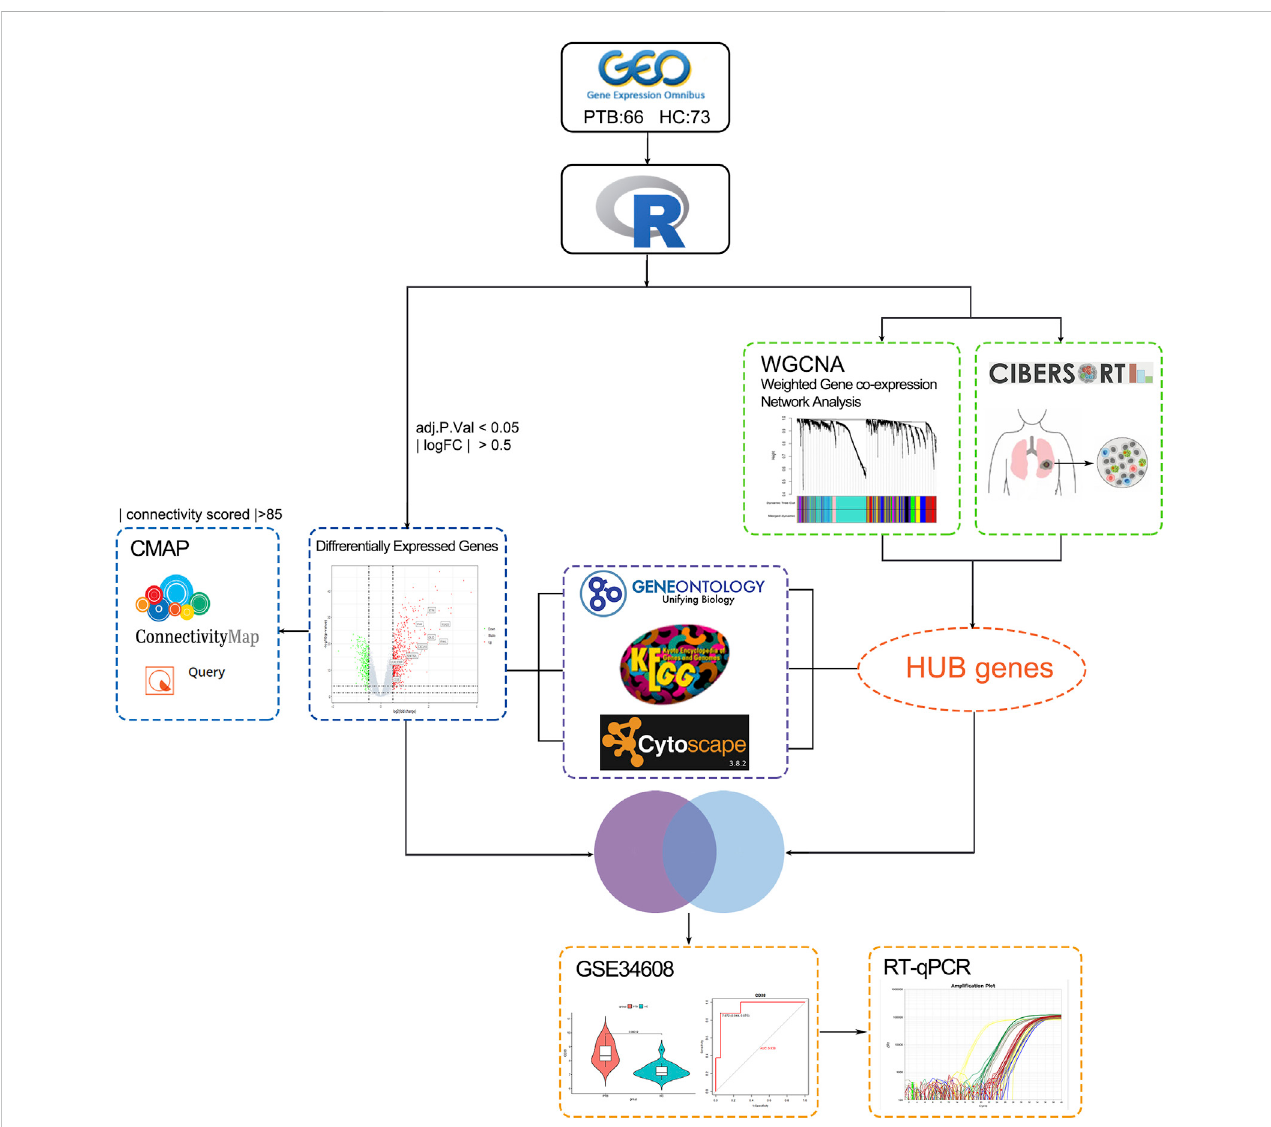
FIGURE 1 The study work fl ow. TB: tuberculosis; GEO: Gene expression omnibus; GO: genes ontology; KEGG: Kyoto Encyclopedia of Genes and Genomes; PPI: protein-protein interaction network; CMap: connectivity Map; CIBERSORT: Estimating Relative Subsets ff RNA Transcripts; WGCNA: weighted gene co- expression network analysis; DEGs: Differentially expressed genes; qRT-PCR; quantitative real-time PCR analysis; ROC curve: receiver operating characteristic